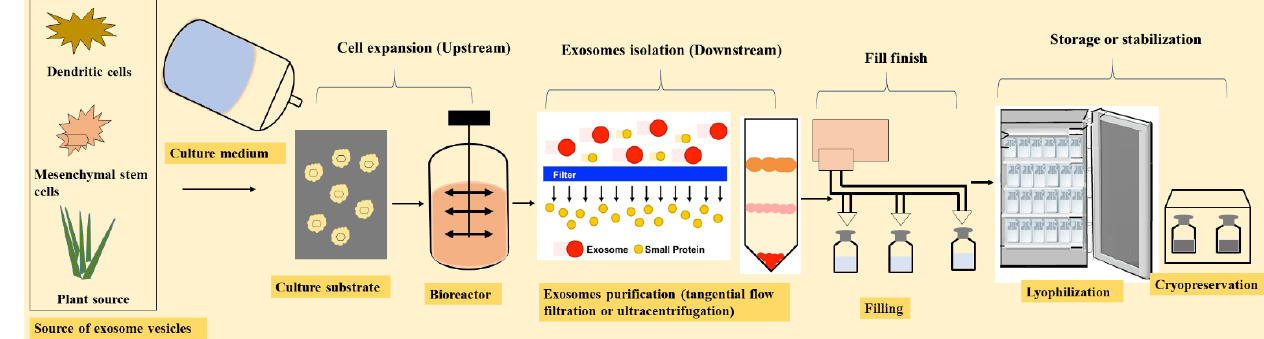
Figure 4. Schematic representation of the manufacturing scheme (upstream and downstream processing) for exosome- based therapeutics. based